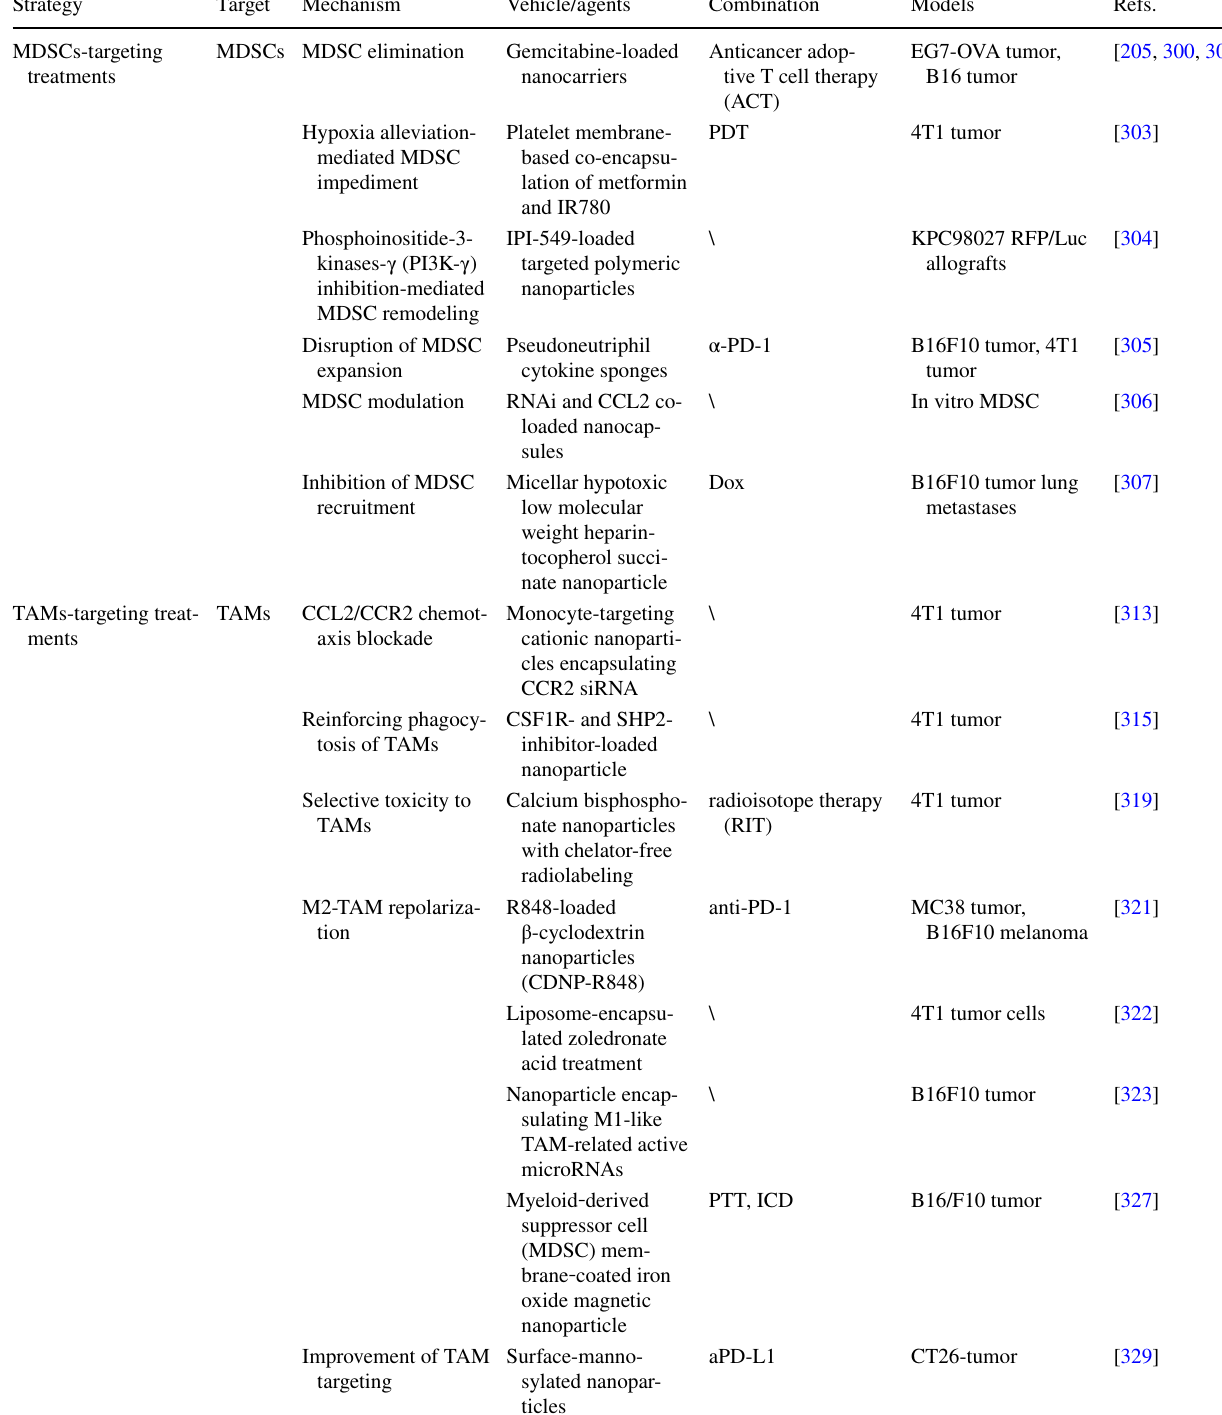
Table 6 Advanced application of nanomedicines for rescuing T cell exhaustion